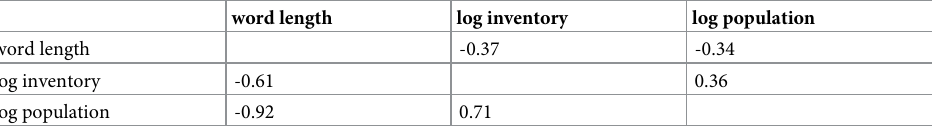
Table 1. Pearson correlations between mean word length, log inventory, and log population. Coefficients in the lower triangle are based on macroarea means, correlated across macroareas; coefficients in the upper triangle are based on individual languages, correlated across